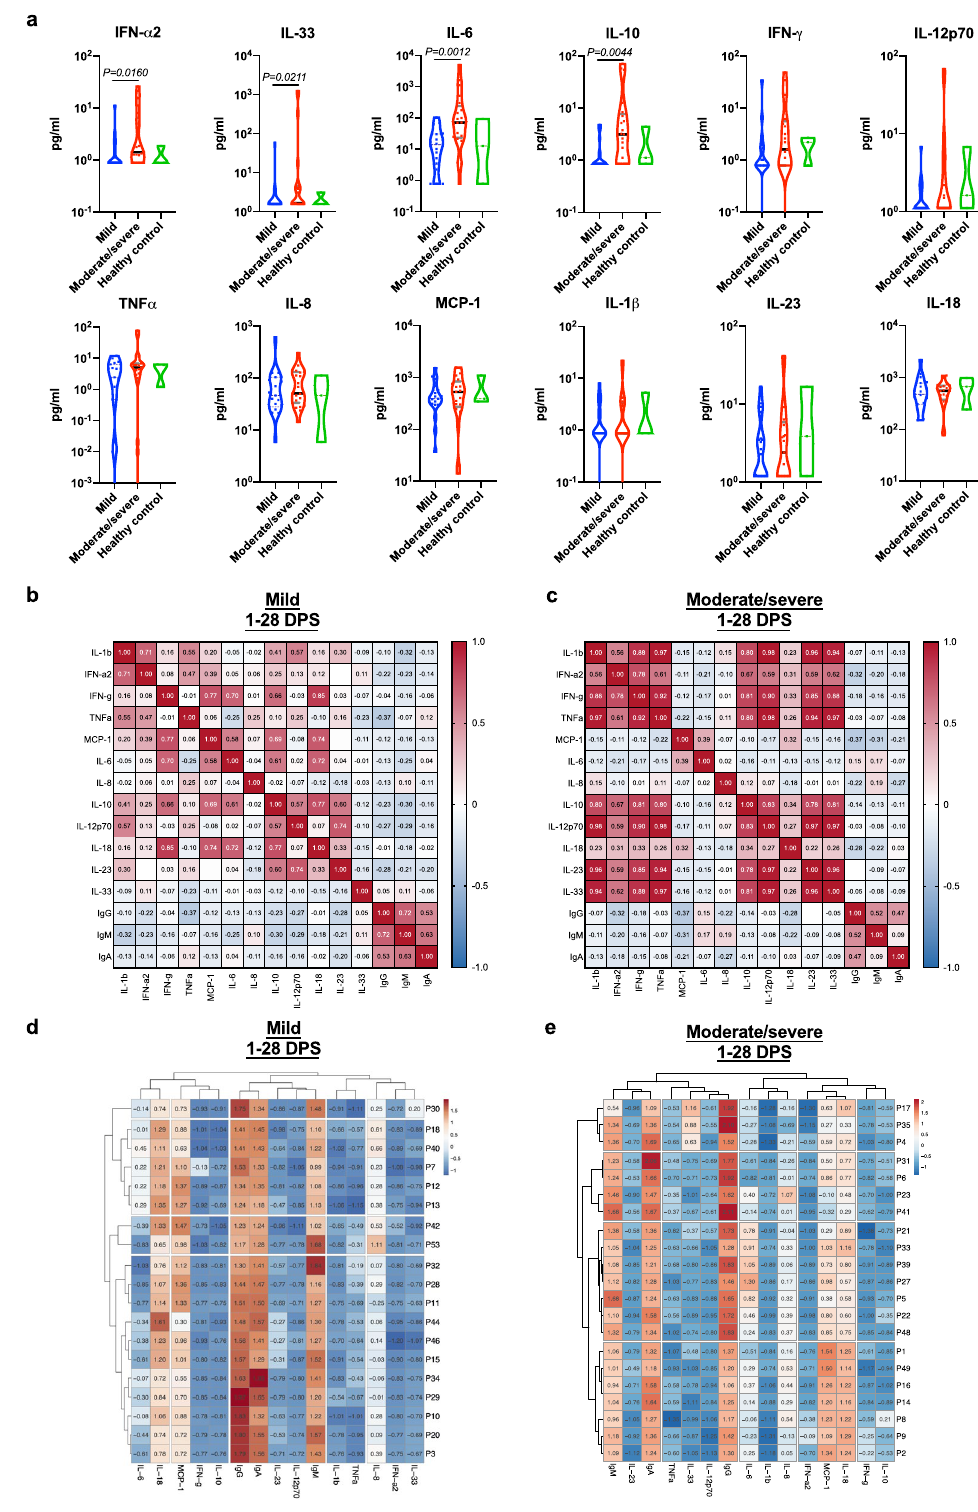
Figure 5. Correlation of the cytokine response to the disease severity and to the antibodies’ response. Peripheral blood was collected from hospitalized COVID-19 patients in their 30 days post symptoms (n = 40). Negative samples were obtained from true SARS-CoV-2 negative patients (i.e., prior to the SARS-CoV-2 pandemic) (n = 3). ( a ) Plasma was obtained, diluted 1:2, and cytokines analysis was performed using 13 multiplex kit, Biolegend. At least 250 beads were acquired per cytokine, using AttuneNxT. Cytokine calculation was performed using LEGENDplex v.8.0 software. A Nonparametric Mann–Whitney test was performed between mild and severe disease patients; P values are shown. ( b , c ) Two tailed (95% confidence) Pearson r correlation between patients’ cytokine and seroconversion toward SARS-CoV2 RBD IgG/M/A antibodies was preformed using GraphPad Prism 8. ( d , e ) Hierarchical clustering of patients’ cytokine and seroconversion toward SARS-CoV2 RBD IgG/M/A antibodies was preformed using ClustVis; Original values are ln(x + 1)-transformed. Rows are centered; unit variance scaling is applied to rows. Both rows and columns are clustered using correlation distance and complete